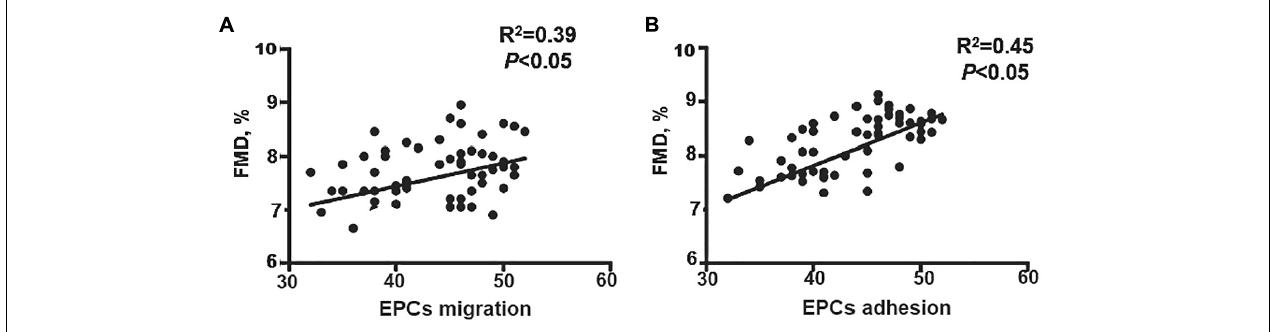
FIGURE 4 | Correlation analysis of EPCs activities and FMD. (A) EPC migration positively correlated with FMD. (B) EPCs adhesion positively correlated with FMD. EECP, enhanced external counterpulsation; EPCs, endothelial progenitor cells; FMD, flow-mediated endothelial dilation; CR, C-reactive protein; Cr, serum creatinine; LDL, low density lipoprotein; FBG, fasting blood glucose.